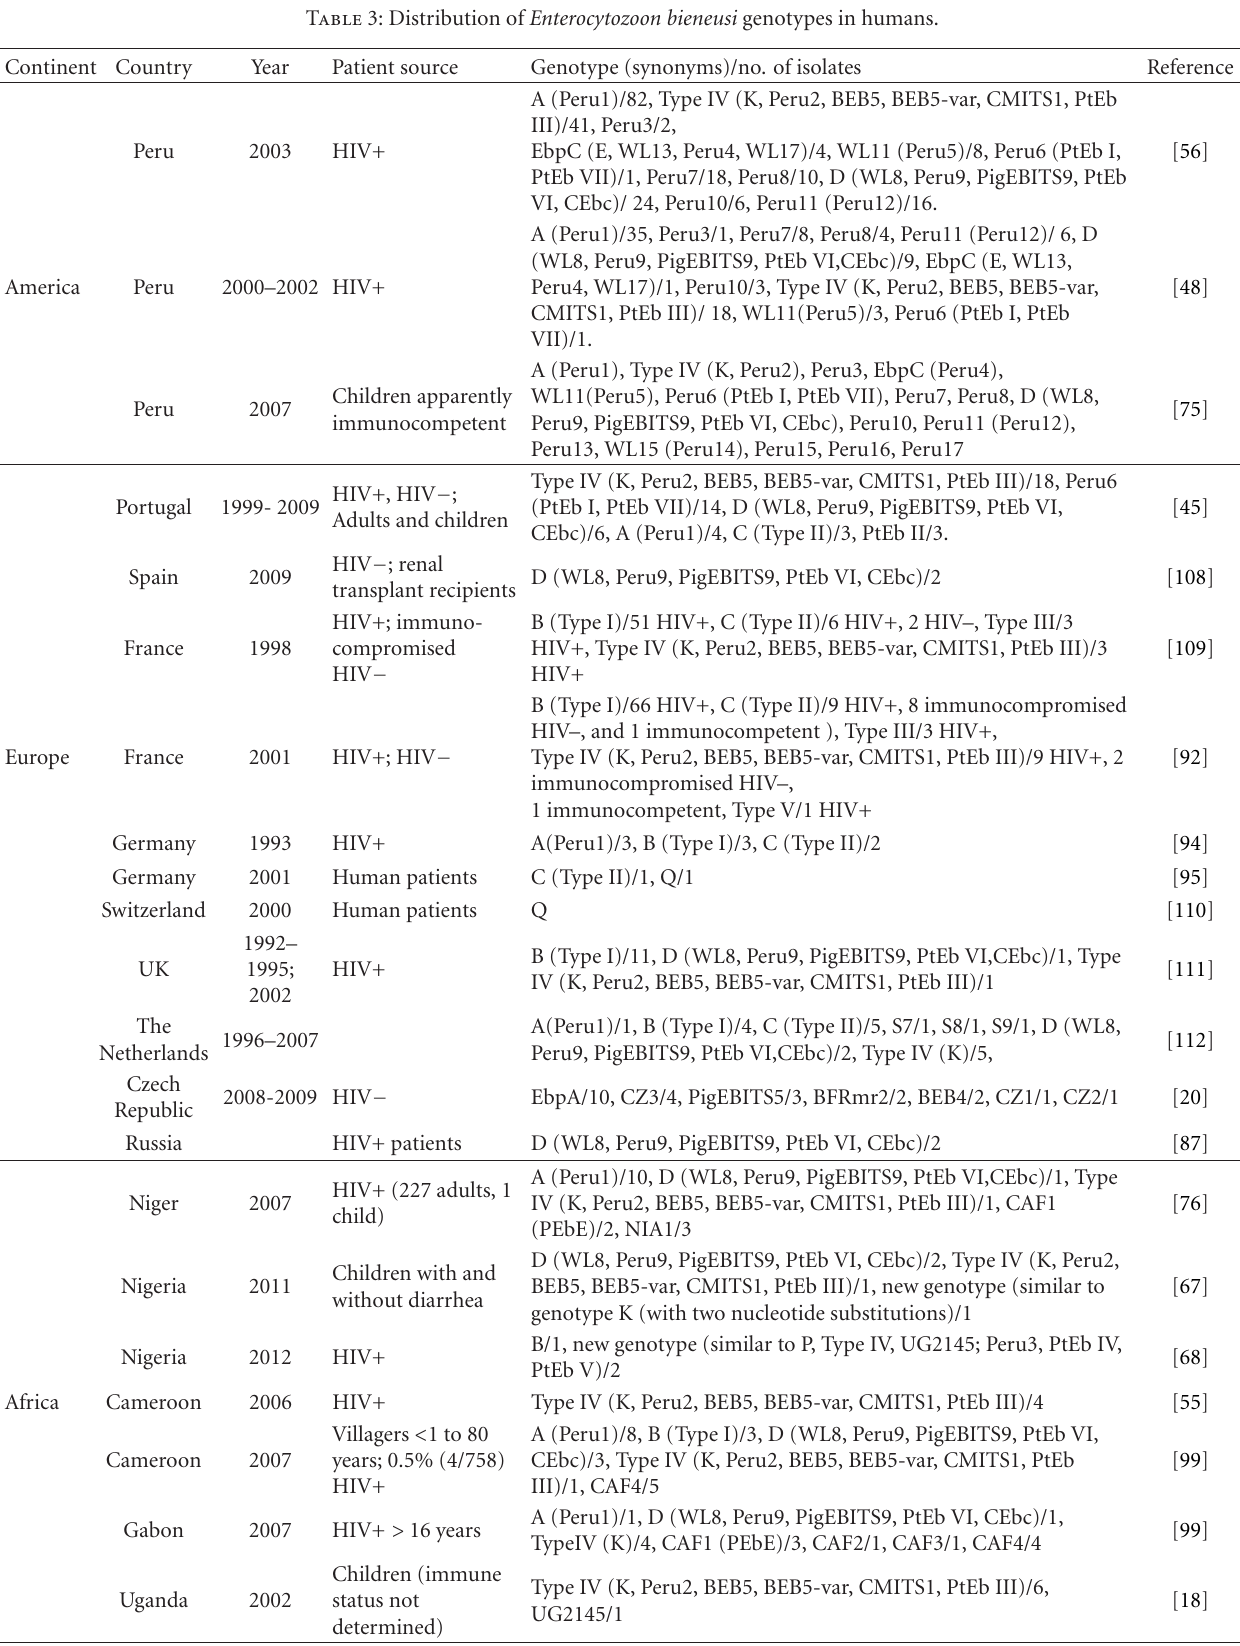
Table 3: Distribution of Enterocytozoon bieneusi genotypes in